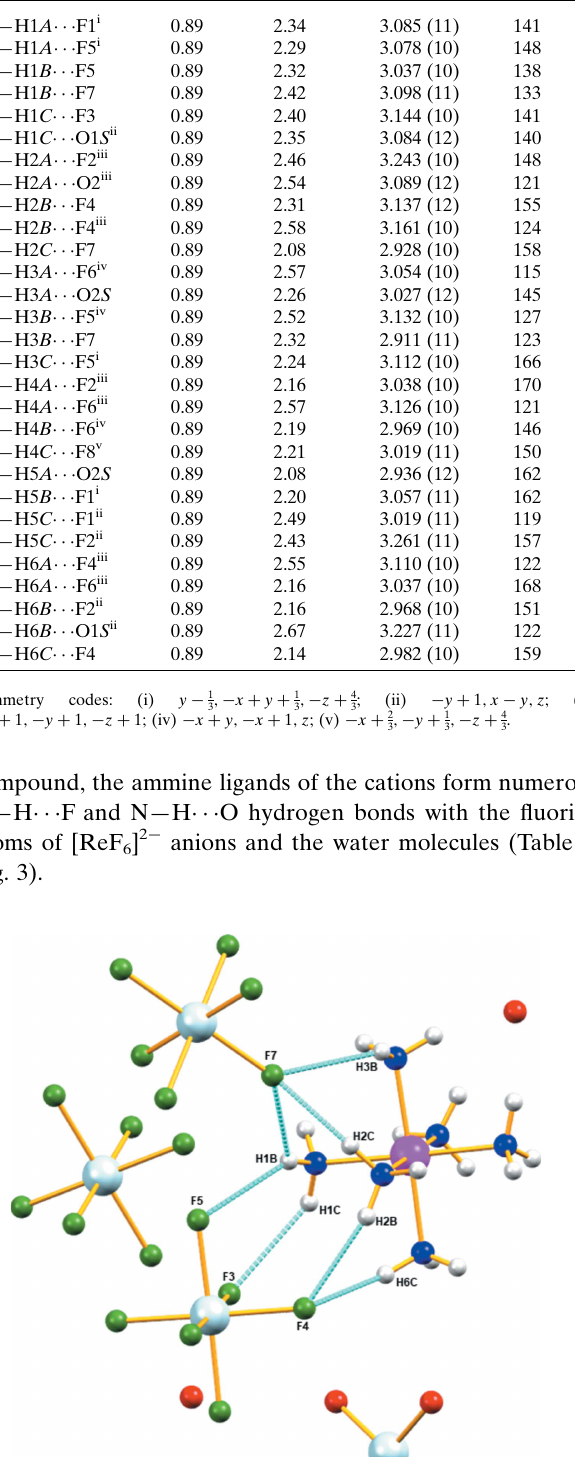
Table 2 Experimental details. Crystal data Chemical